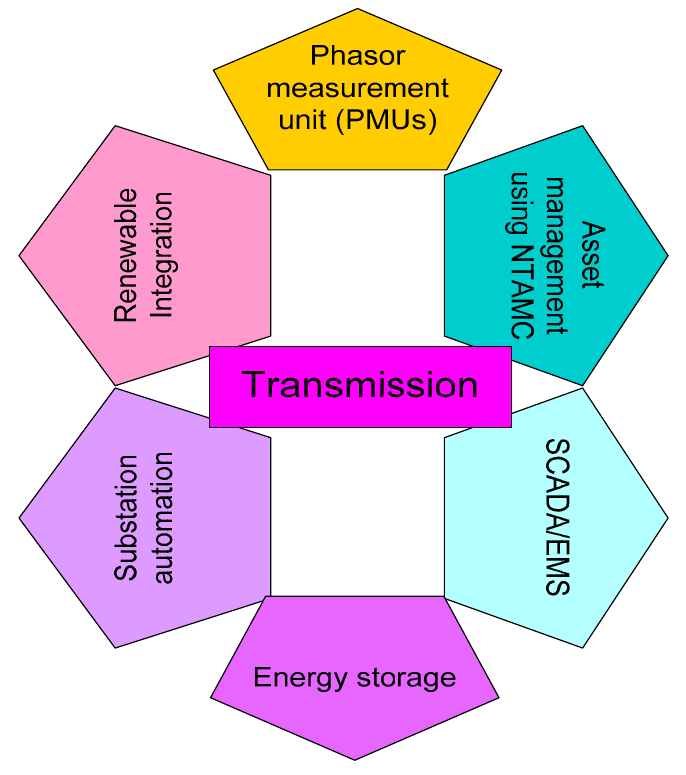
Figure 5. Application of IoT for electricity transmission. Hard winds and strong snowy conditions lead to lines that cause the asymmetrical pulling force to be exerted on lines, which may lead to towers leaning [107]. These factors harm overhead lines that increase operational risk. Maintenance and remote